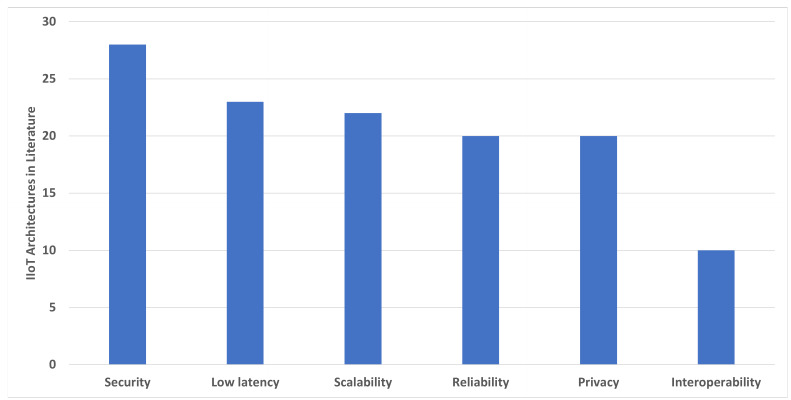
Figure 8. Literature focus on key IIoT requirements.